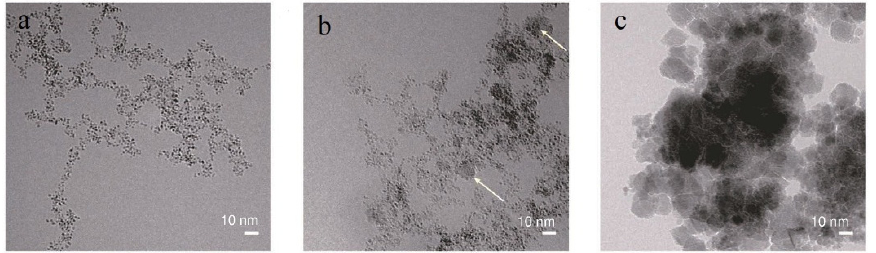
Figure 5. TEM images of magnetite particles aggregated to form nuclei: ( a ) 2 min, ( b ) 6 min, and ( c ) 82 min. Arrows in ( b ) indicate early formed crystalline magnetite nanoparticles. The figure is reproduced with copyright permission of ref. [50].